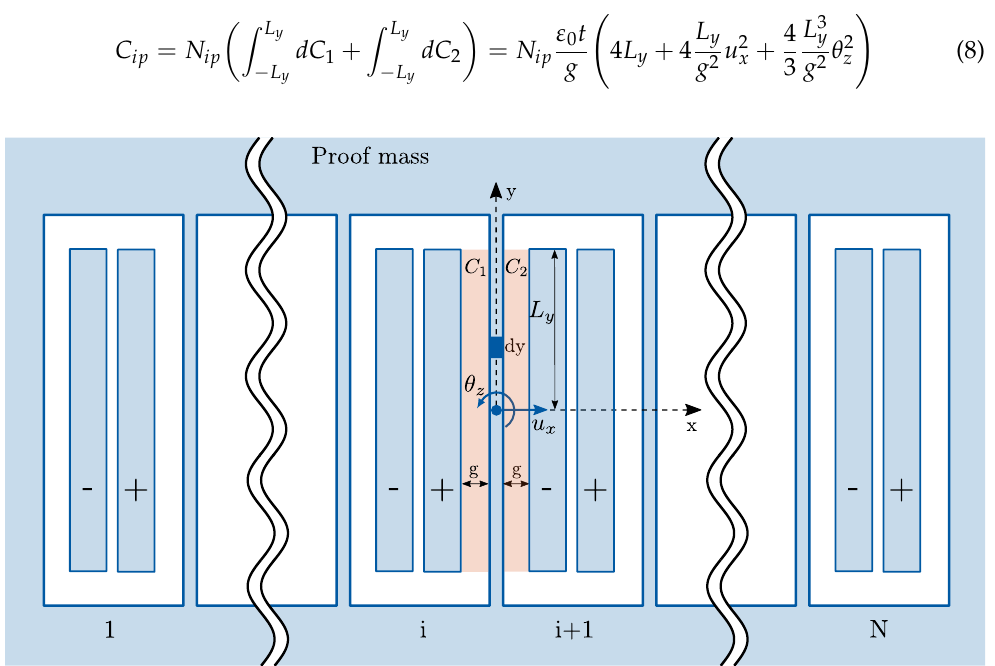
Figure 7. Scheme of an in-plane capacitor as a function of u x , θ z